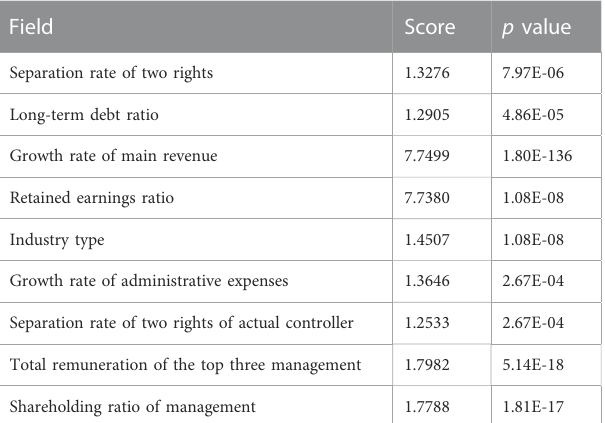
TABLE 7 Statistical table of p value score.